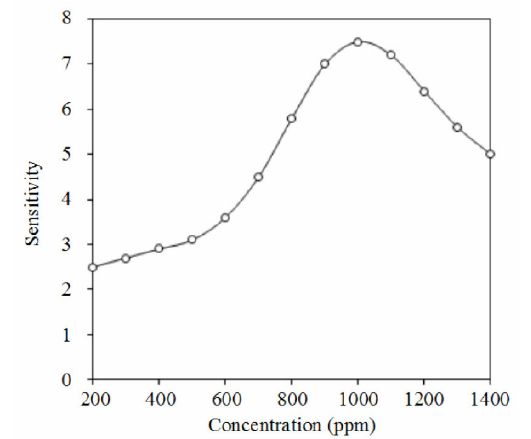
Fig. 5 Measured sensitivity of NiCo 2 O 4 thin films to the